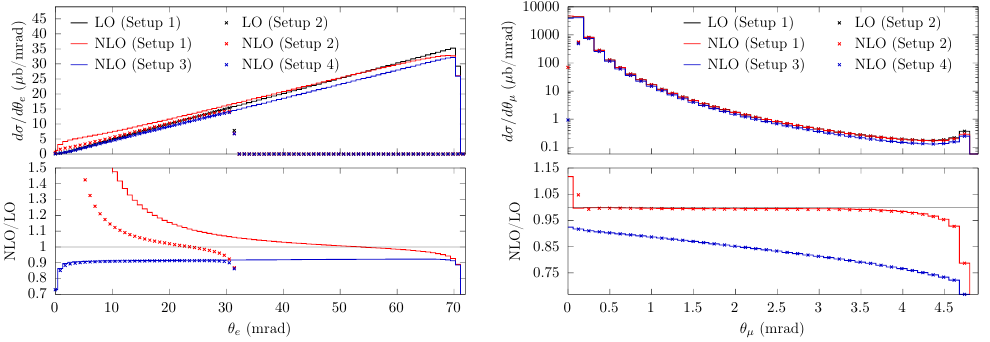
Figure 4 . Left plot: the LO and NLO QED cross sections of the µ + e − → µ + e − process, as a function of the electron scattering angle, for the different setup described in the text (upper panel); relative NLO QED corrections (lower panel). Right plot: the same as in the left plot, as a function of the muon scattering